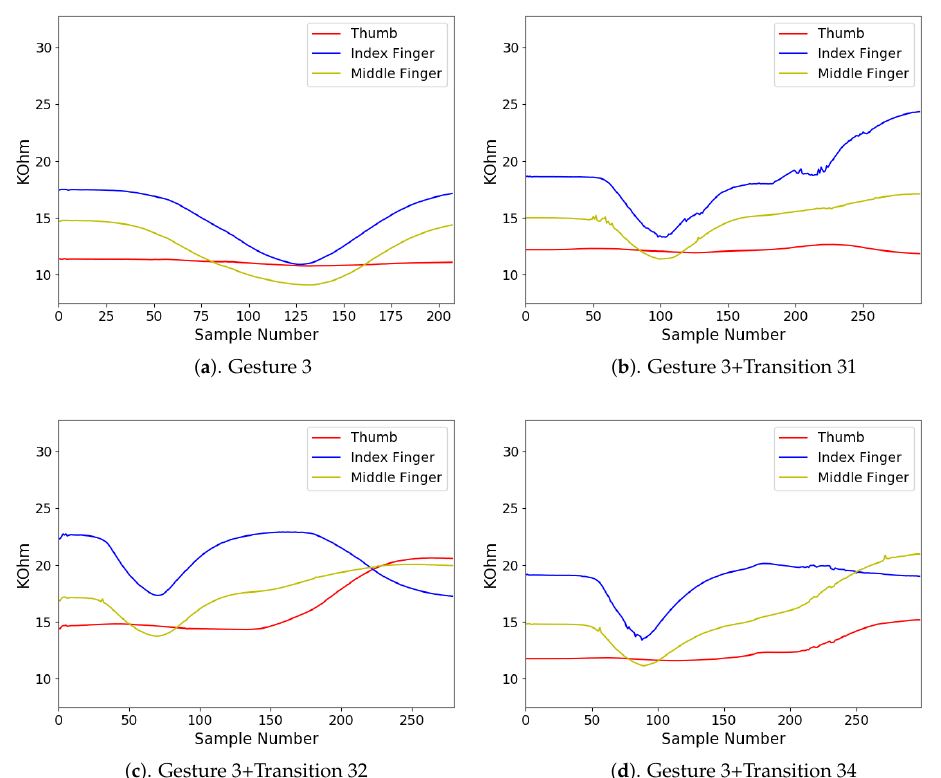
Figure 16. The measured sensory data produced by flex sensors of the smart glove for gesture class